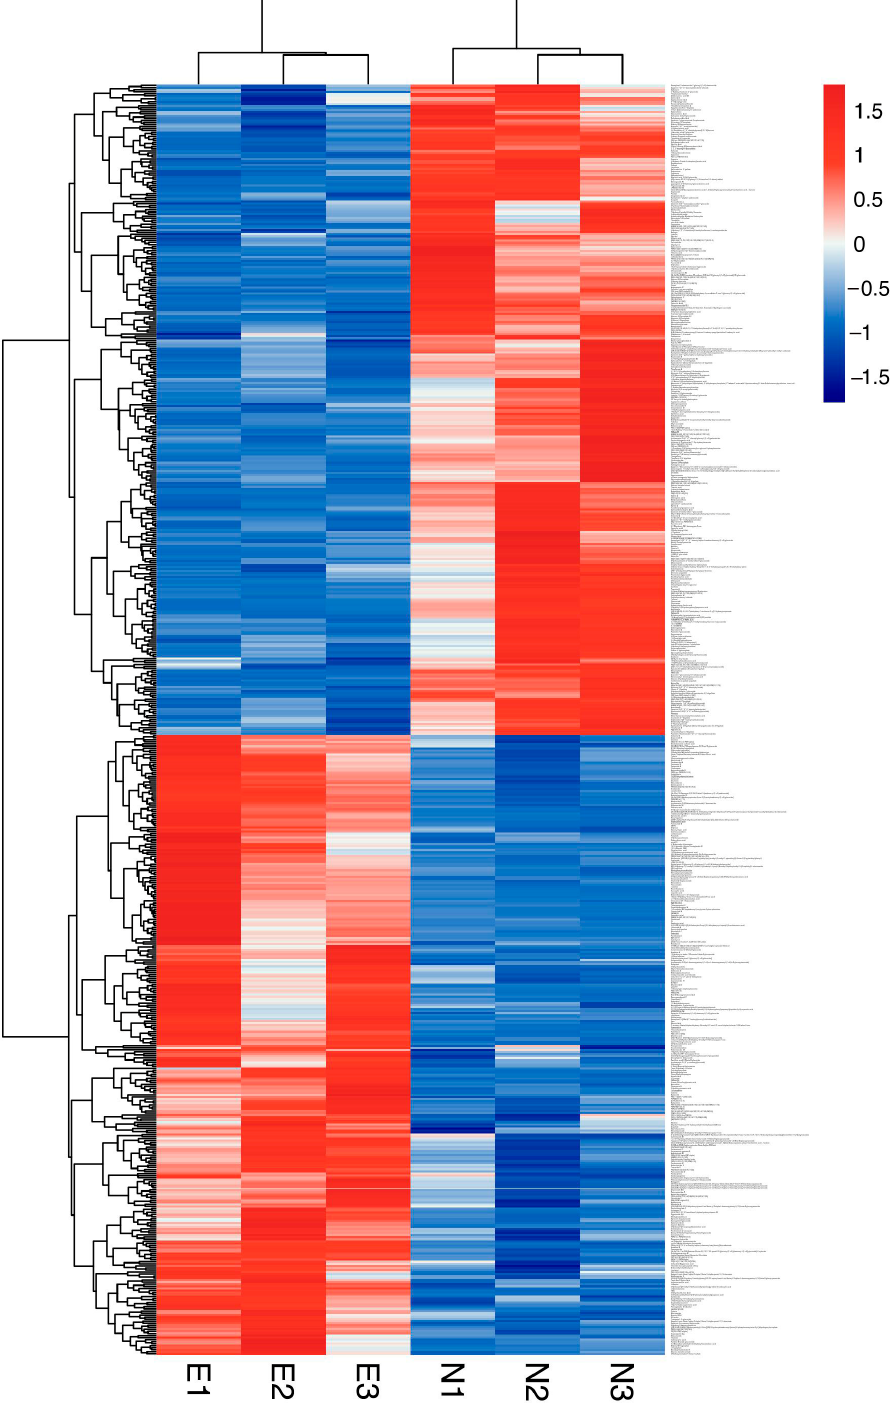
Figure 7. Hierarchical clustering of the differentially abundant metabolites based on combination with GC-MS and LC-MS. The data were log2 transformed, and similarity assessment for clustering was based on the Euclidean distance coefficient and complete clustering algorithm. Columns and rows represent individual metabolites and different samples respectively. E1, E2 and E3 represents the groups of the leafhopper feeding, N1, N2 and N3 represents the groups of leafhopper not feeding.